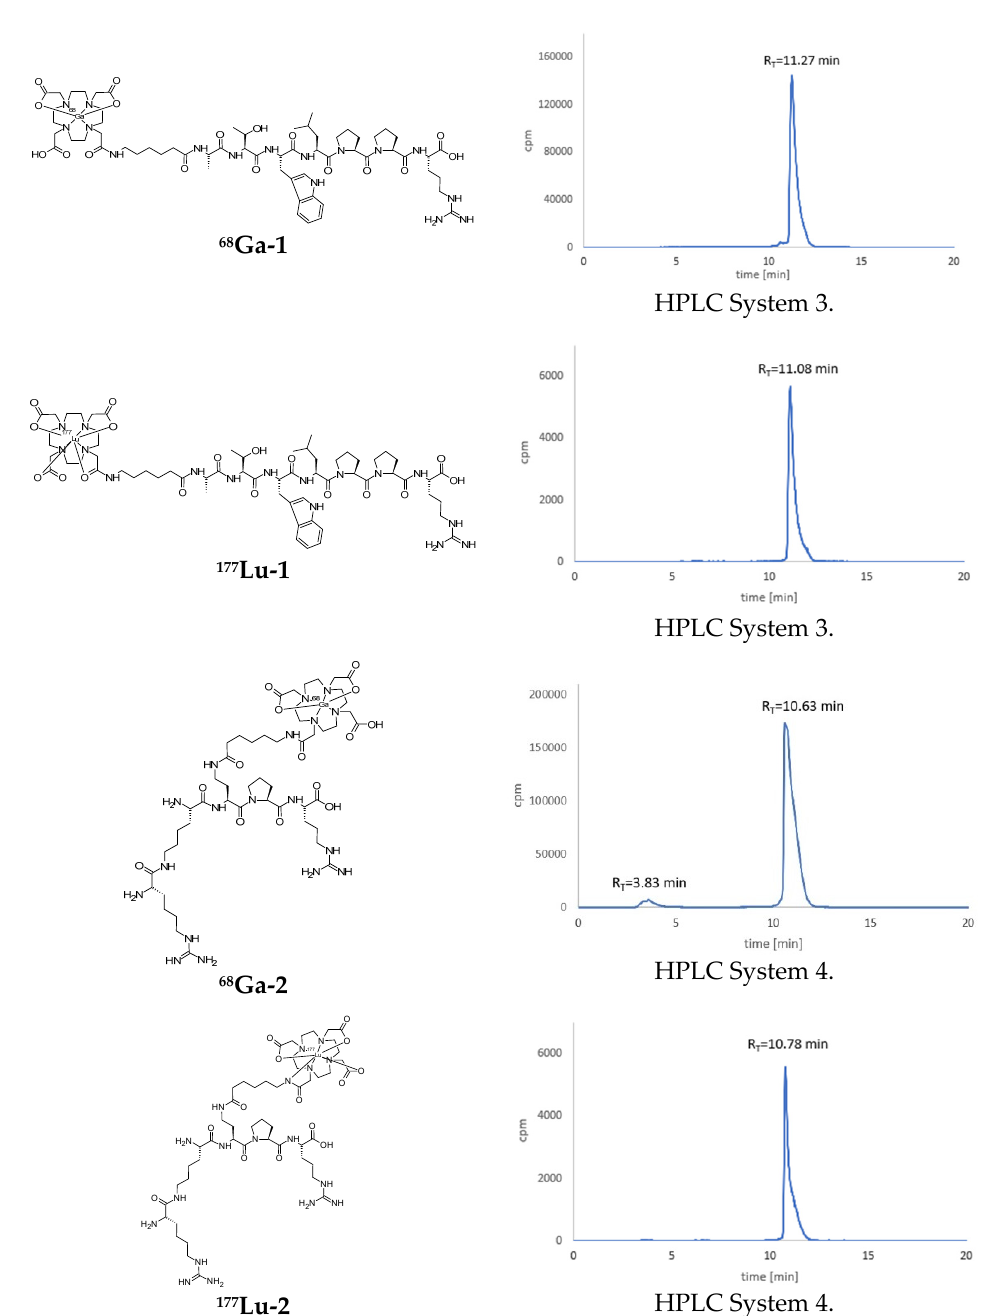
Figure 2. The statistical data of the radiochemical yield (RCY) and radiochemical purity (RCP) (presented as the mean ± SD, n = the number of repetitions) of the obtained 68 Ga-1 , 177 Lu-1 , 68 Ga-2 , and 177 Lu-2 radioconjugates are presented in Table 2.